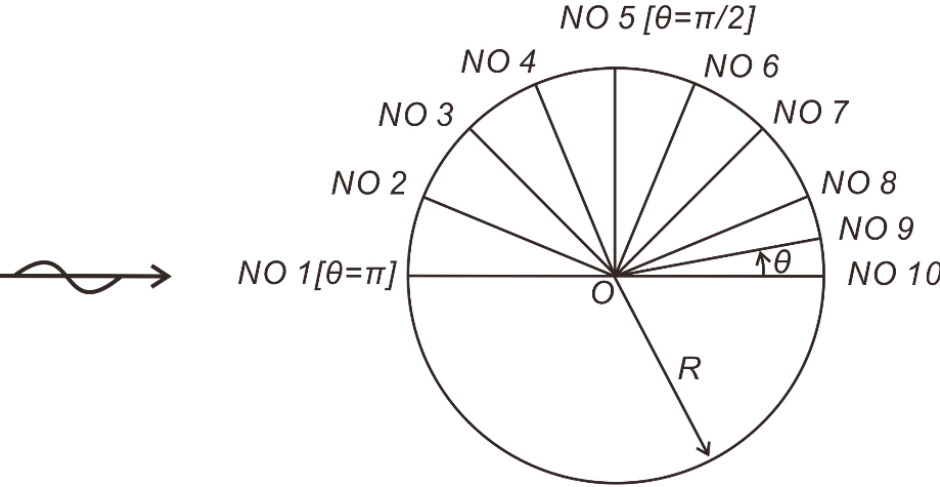
Figure 16. Location of gauges NO 1 through NO 10.